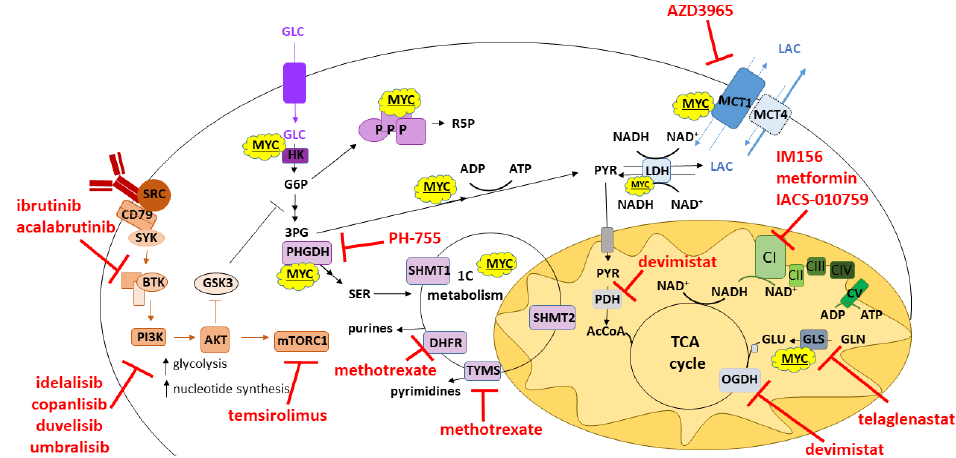
Figure 2. Metabolic inhibitors and their targets in B-cell lymphoma. Pro-proliferative kinase signaling downstream of the BCR can be targeted by inhibiting BTK (e.g., ibrutinib or acalabrutinib), PI3K (e.g., idelalisib, copanlisib, duvelisib, umbralisib) and mTORC1 (e.g., temsirolimus). Enzymes involved in glucose and 1C metabolism can be inhibited at the point of serine synthesis via PHGDH (e.g., PH-755) and tetrahydrofolate regeneration by dihydrofolate reductase (methotrexate) and thymidylate synthesis by thymidylate synthase (e.g., methotrexate). Lactate efflux can be blocked by inhibition of MCT1 by AZD3965. Mitochondrial carbon metabolism can be targeted via inhibition of glutaminase (e.g., telaglenastat) and by inhibiting lipoate dependent enzymes pyruvate dehydrogenase and oxoglutarate dehydrogenase (e.g., devimistat). Mitochondrial oxidative phosphorylation and NADH oxidation can be targeted by specific inhibition of respiratory complex I (e.g., IM156, metformin, IACS-010759).